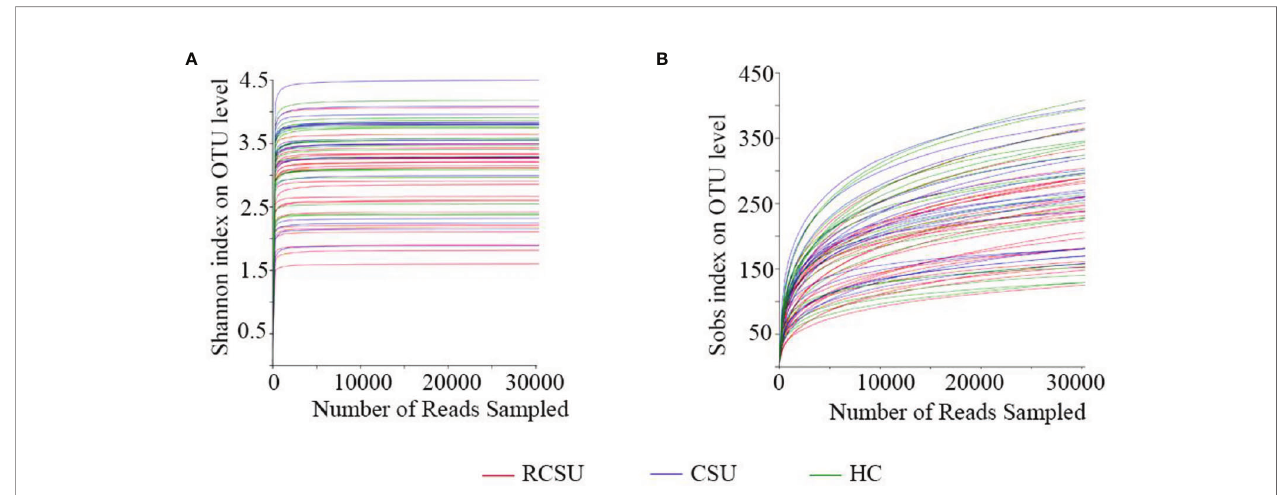
FIGURE 1 | Analysis of 16s rRNA sequencing depth. Refraction curve analysis with Shannon (A) or Sobs index (B) on OTU level.